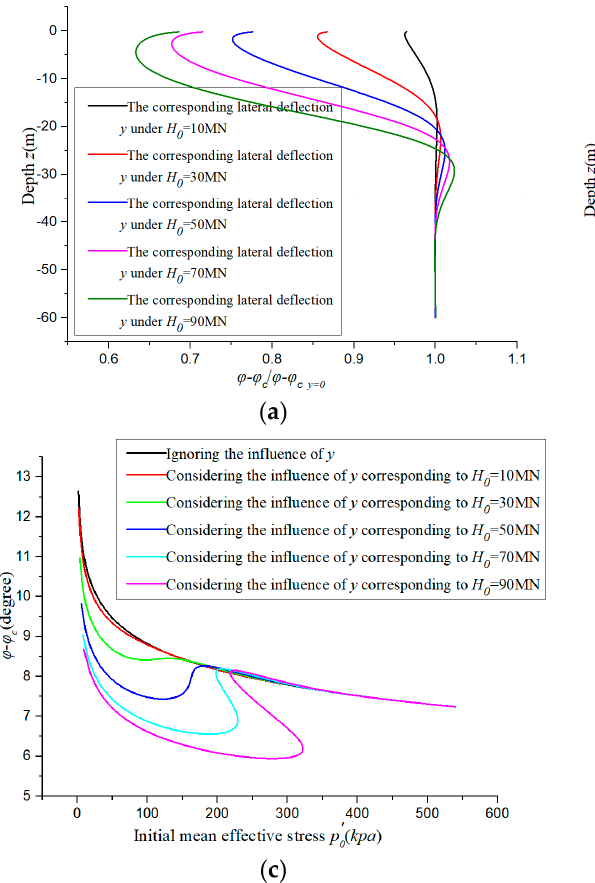
Figure 12. The in fl uence of lateral de fl ection y of pile on mean e ff ective stress-internal friction angle Figure 12. The influence of lateral deflection y of pile on mean effective stress-internal friction angle state of sand: ( a ) φ − φ (cid:2913) /φ − φ (cid:2913)(cid:2935) state of sand: ( a ) ϕ − ϕ c / ϕ − ϕ c relationship between φ − φ (cid:2913) and p (cid:2868)(cid:4593) . relationship between ϕ − ϕ c and p (cid:48)